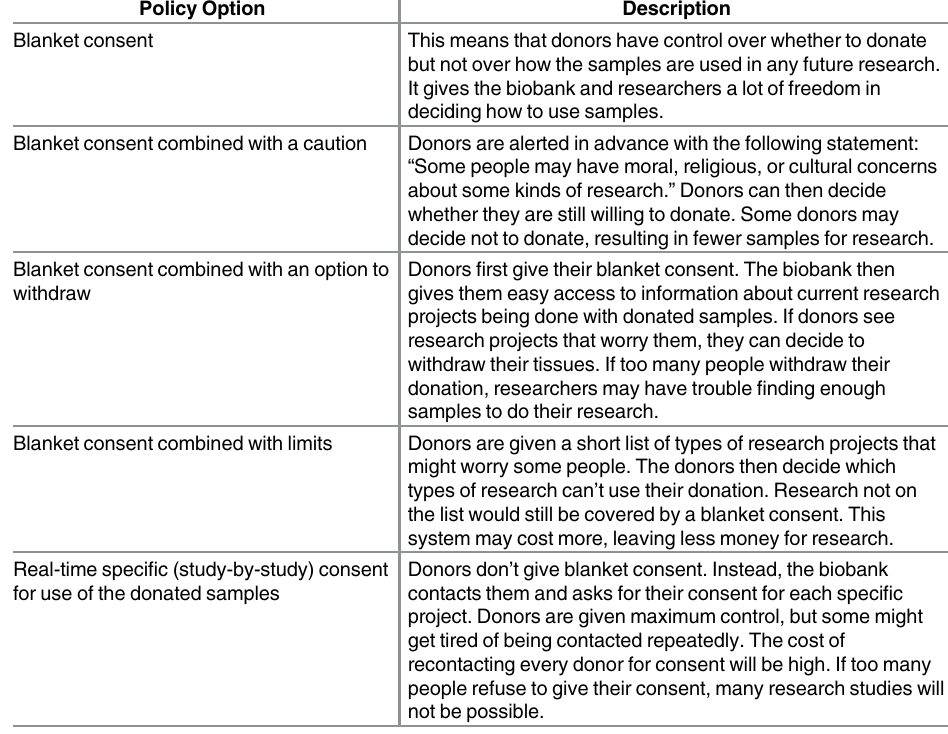
Table 2. Societal policy options for biobank